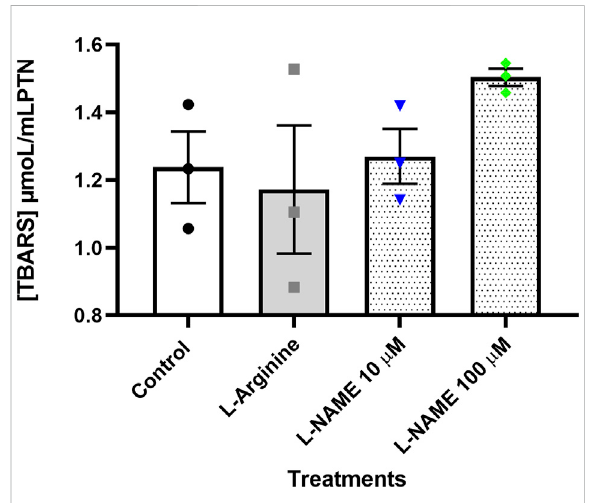
Concentration of thiobarbituric acid reactive substances (TBARS) given in µmoL/ml PTN in the thymus-derived endothelial cell line tEnd.1 medium after treatment with L-arginine (100 µM) and L-NAME (10 and 100 µM) for 72 h without retreatment. Data (mean, n = 3) were compared by Two-way ANOVA. No statistical differences were observed between